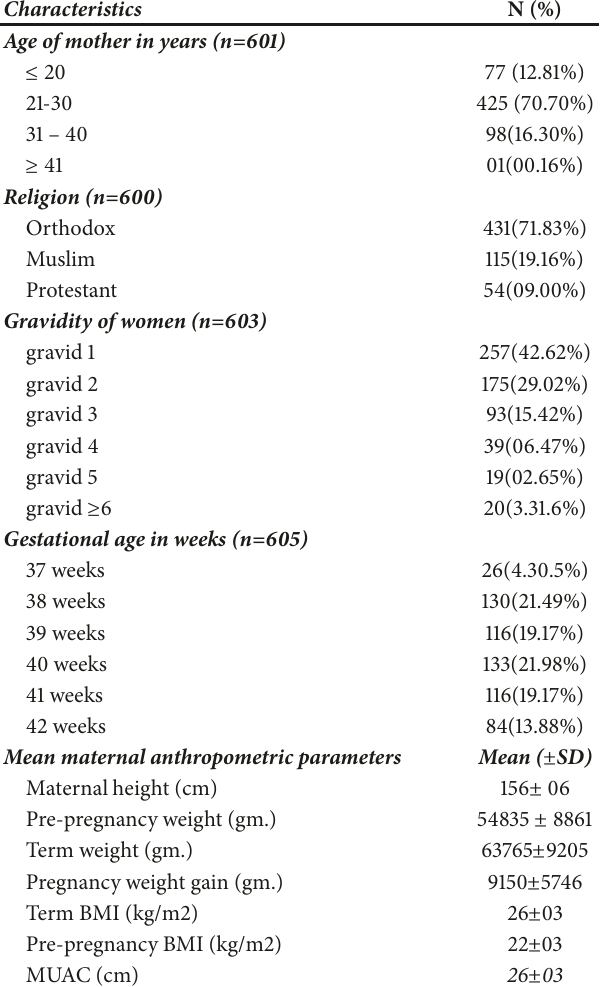
Table 1: Maternal age, gravidity, gestational age, and anthropomet- ric characteristics of women at public hospitals in Addis Ababa city, Ethiopia, Nov 25, 2012 to Feb 25, 2013